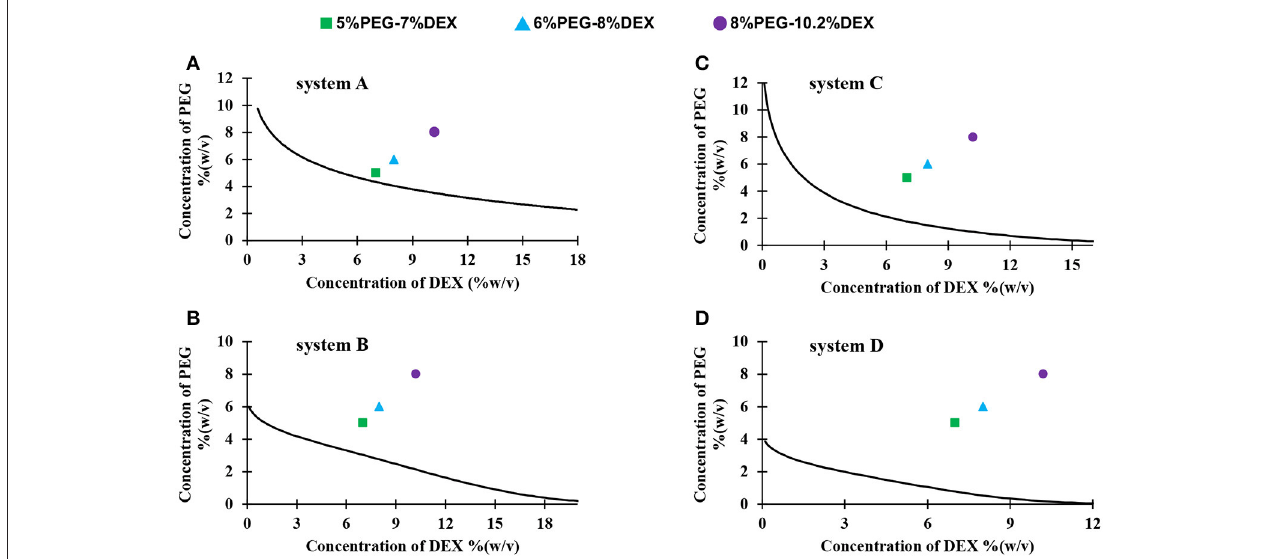
FIGURE 1 | Binodal curves of four systems made with different molecular weights PEG and DEX: (A) PEG8k-DEX40k, (B) PEG8k-DEX500k, (C) PEG35k-DEX40k, and (D) PEG35k-DEX500k. Colored symbols show the resulting concentrations of PEG and DEX in the partition assay; square: 5%PEG-7%DEX, triangle: 6%PEG-8%DEX, and circle: 8%PEG-10.2%DEX.